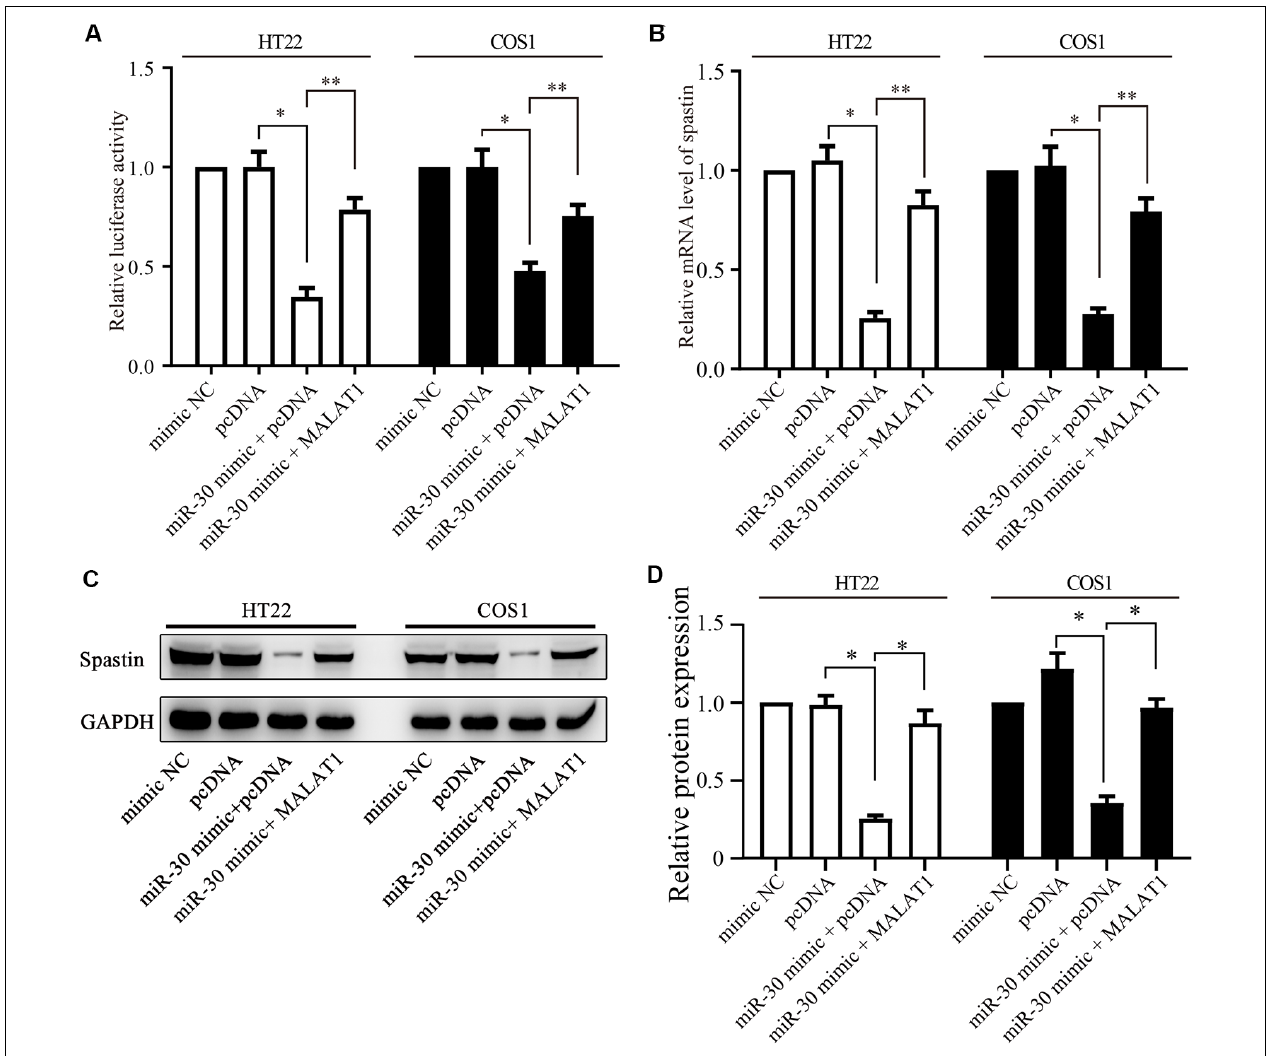
FIGURE 5 | MALAT1 regulates spastin expression through miR-30. (A) HT22 and COS1 cells were co-transfected with the spastin luciferase reporter plasmid together with miR-30 or with miR-30 and MALAT1; or with controls. The relative luciferase activity is shown. (B) mRNA and protein expression (C) of spastin was determined by qPCR and western blotting in HT22 and COS1 cells transfected with the indicated plasmids or mimics. (D) Relative protein expression of spastin vs. GAPDH from (C) was quantified. ∗ P < 0.05, ∗∗ P < 0.01; n =